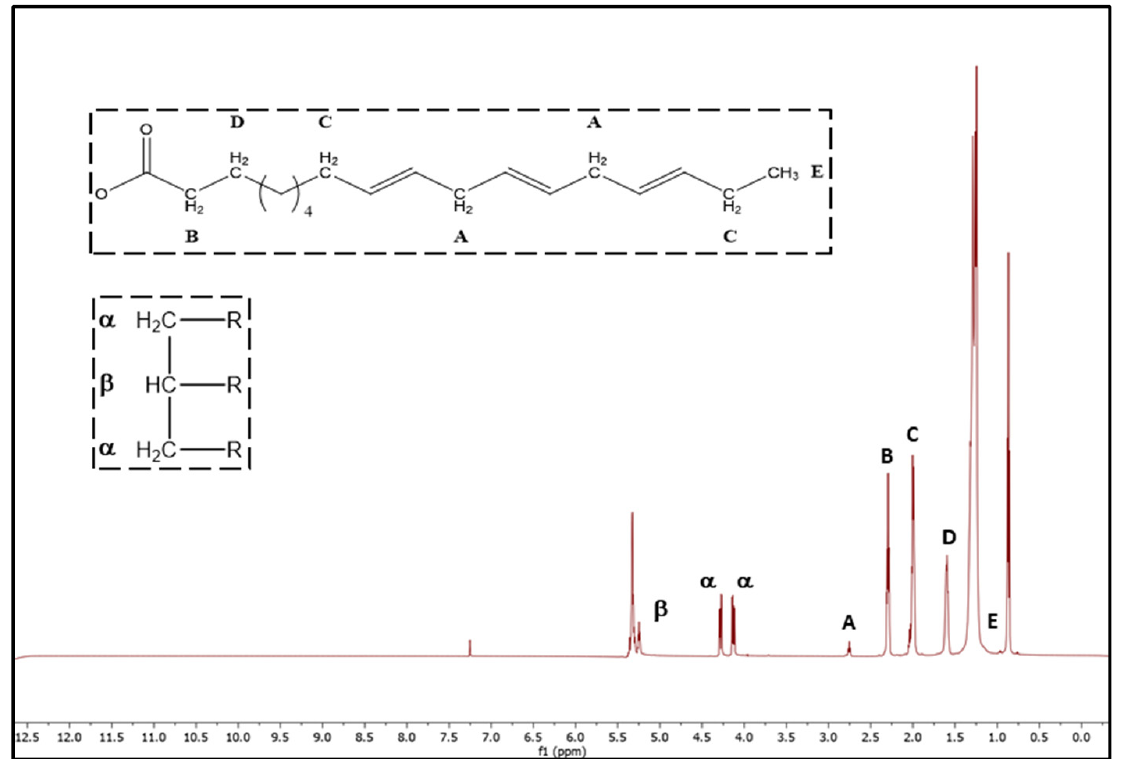
Figure 2. Structure of FAs and 1 H-NMR spectrum at 400 MHz of camelia seed oil.